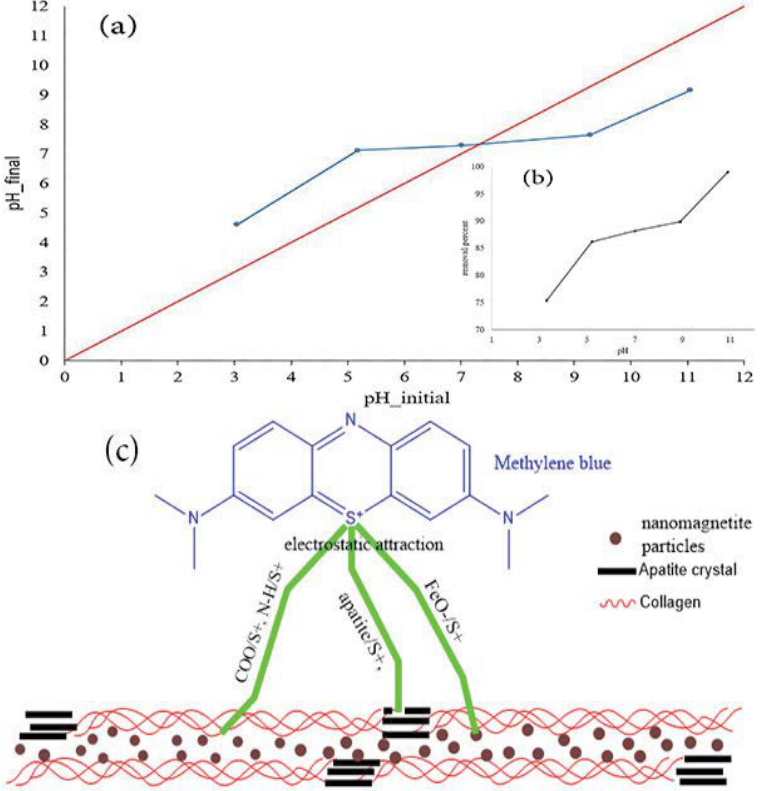
Fig. 8. (a) Plot for determination of pH pzc for MFS, (b) Effect of the initial pH of MB solution onto the removal of MB and (c) Schematic diagram of MB dye adsorption onto MFS.